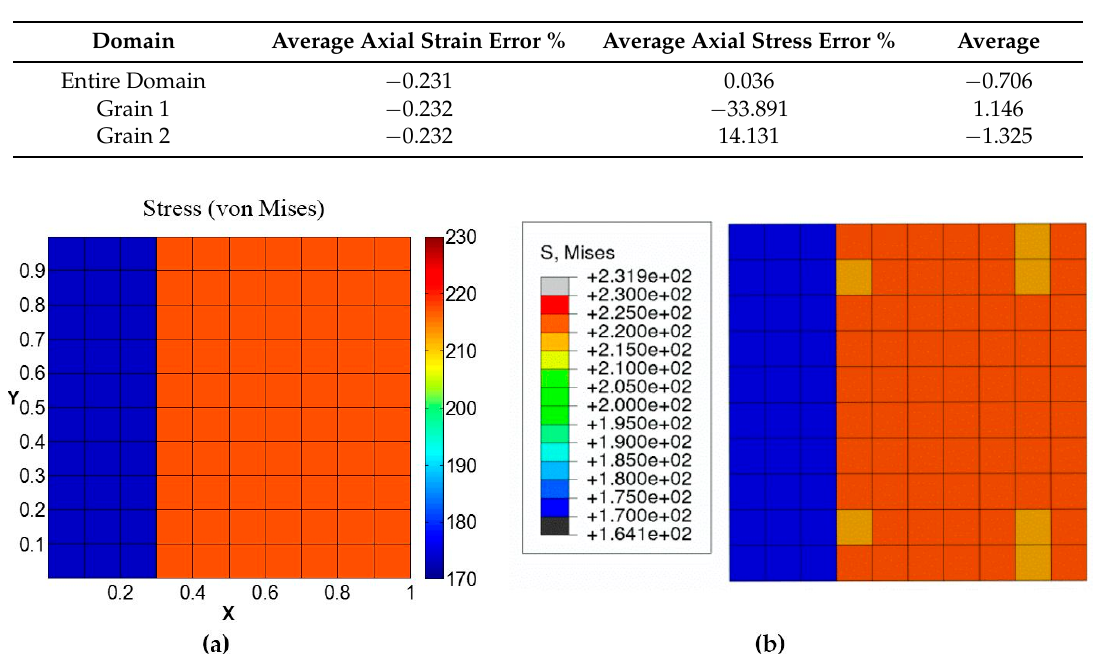
Figure 6. Von Mises stress distribution on a cross-section taken midway through the length in the loading direction for the two-grain polycrystal model by: ( a ) GMC; ( b ) FEA.